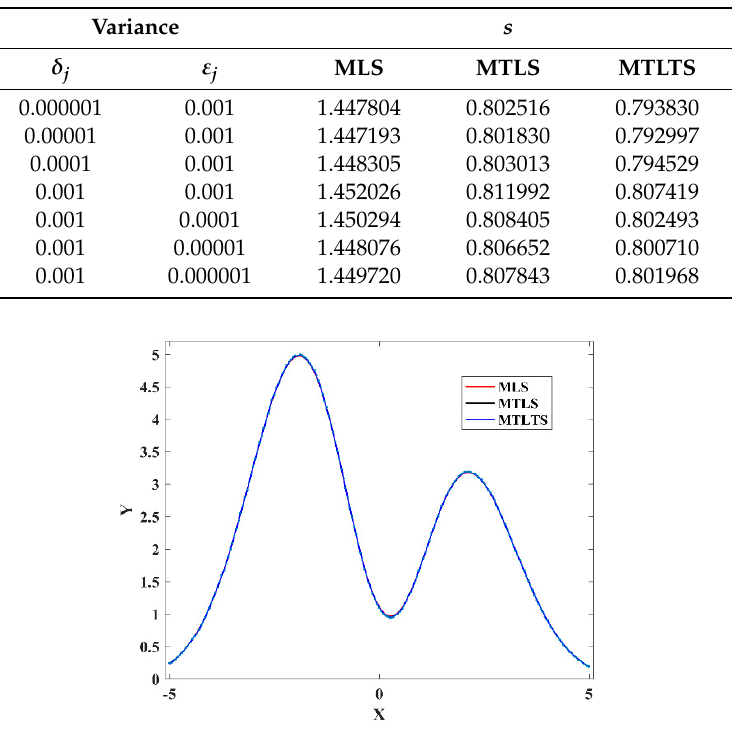
Figure 6. Fitting curves obtained by the Moving Least Squares (MLS), Moving Total Least Squares (MTLS), and MTLTS.